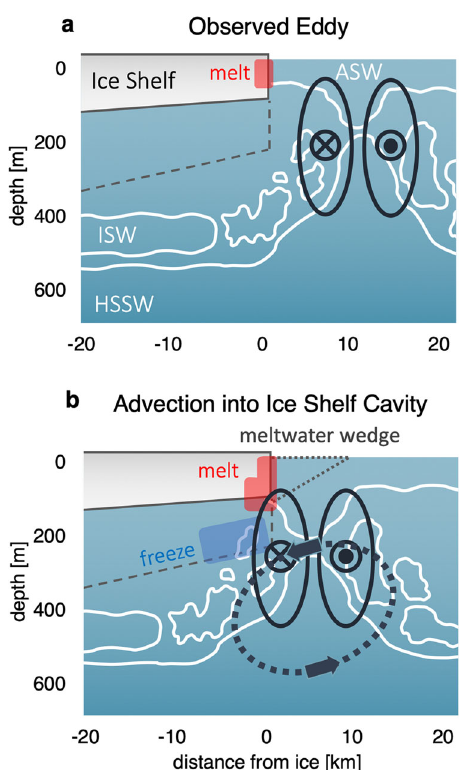
Fig. 9 Eddy schematic. a The observed eddy just offshore of the NIS, resulting in minimal heat exchange with the ice base. b A hypothesized case of shoreward advection of the observed eddy due to external forcing (arrows), resulting in localized regions of enhanced melt (red) and refreezing (blue) on the underside of the ice shelf. The grey polygon represents the minimum ice shelf thickness within the NIS basal channel, while dashed grey lines show the maximum ice shelf thickness outside of the channel. Tall ovals indicate the extent of the eddy, where × and ∘ indicate motion into and out of the page, respectively. White lines indicate the locations of water masses supported by observations from this